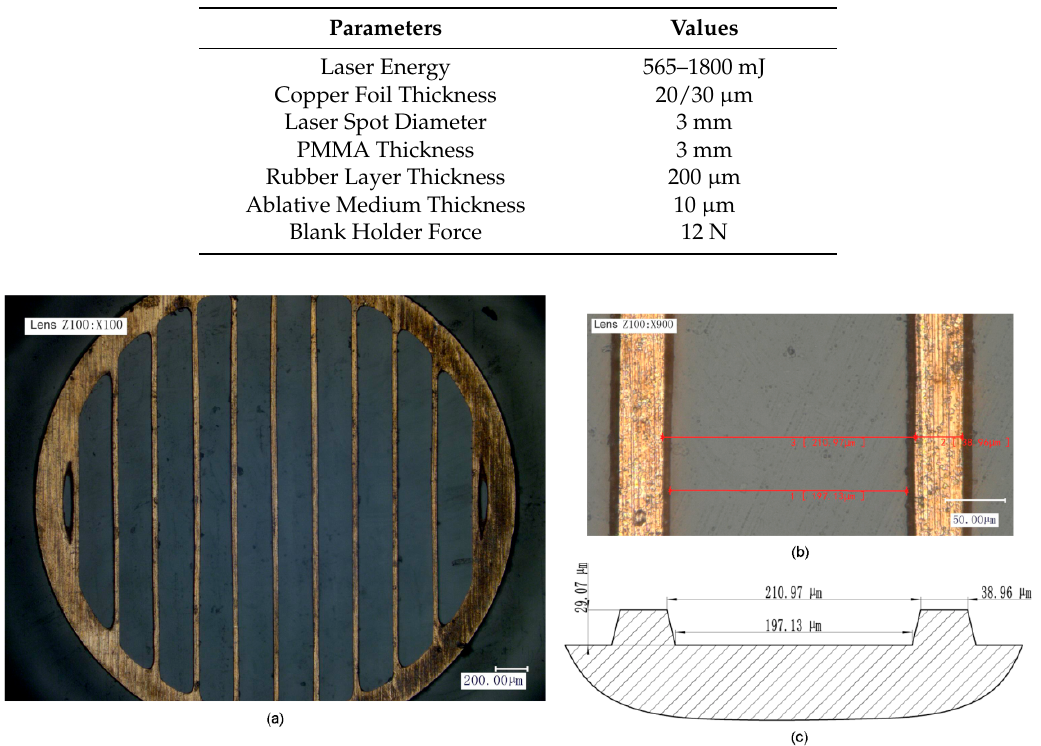
Table 1. Detailed experimental parameters.